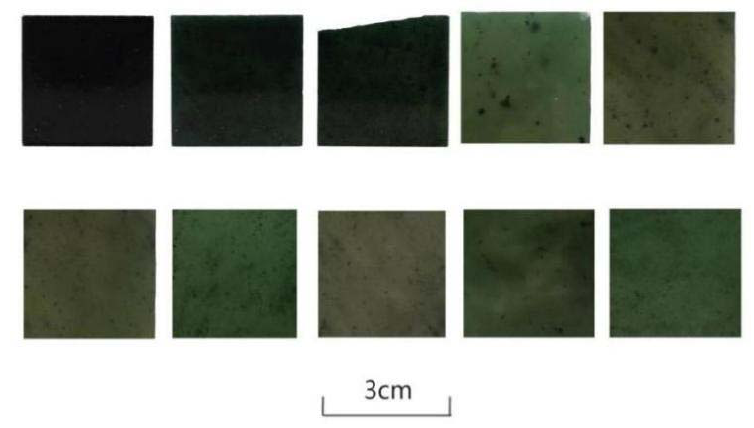
Figure 1. Some of the serpentine jade samples